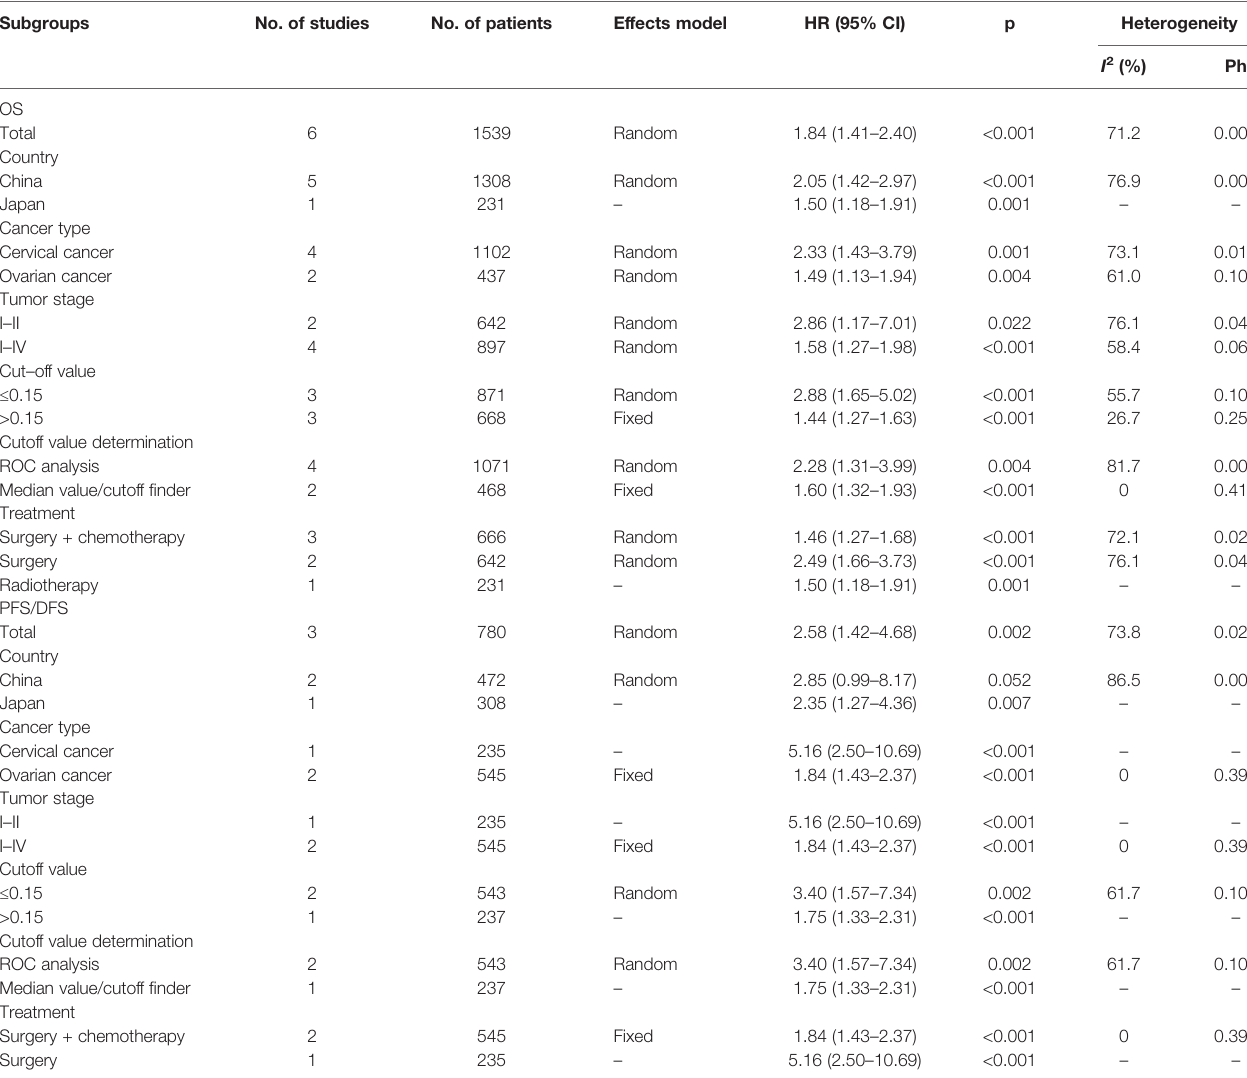
TABLE 3 | Subgroup analysis of the prognostic value of CRP/Alb for OS and PFS/DFS in patients with gynecological cancers.